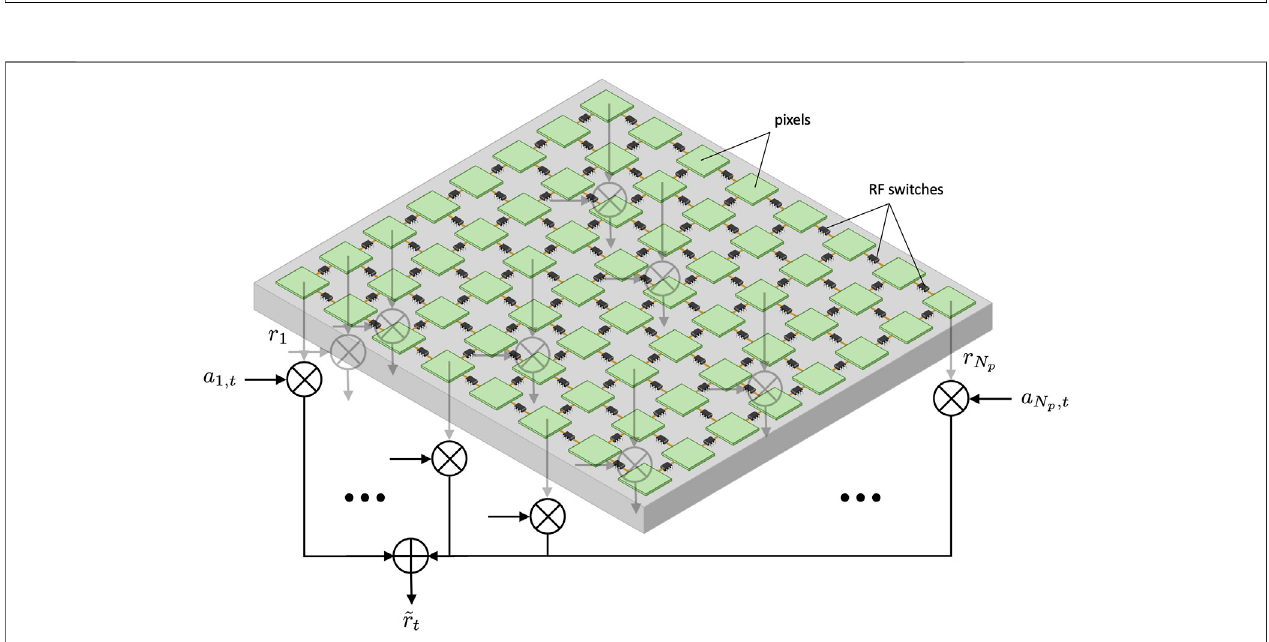
Frontiers in Communications and Networks |